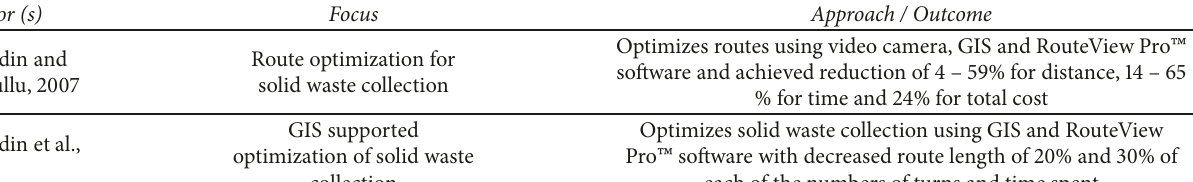
Table 3: Studies combining more than one approach for optimal routing of waste collection trucks (nonexhaustive list). Author